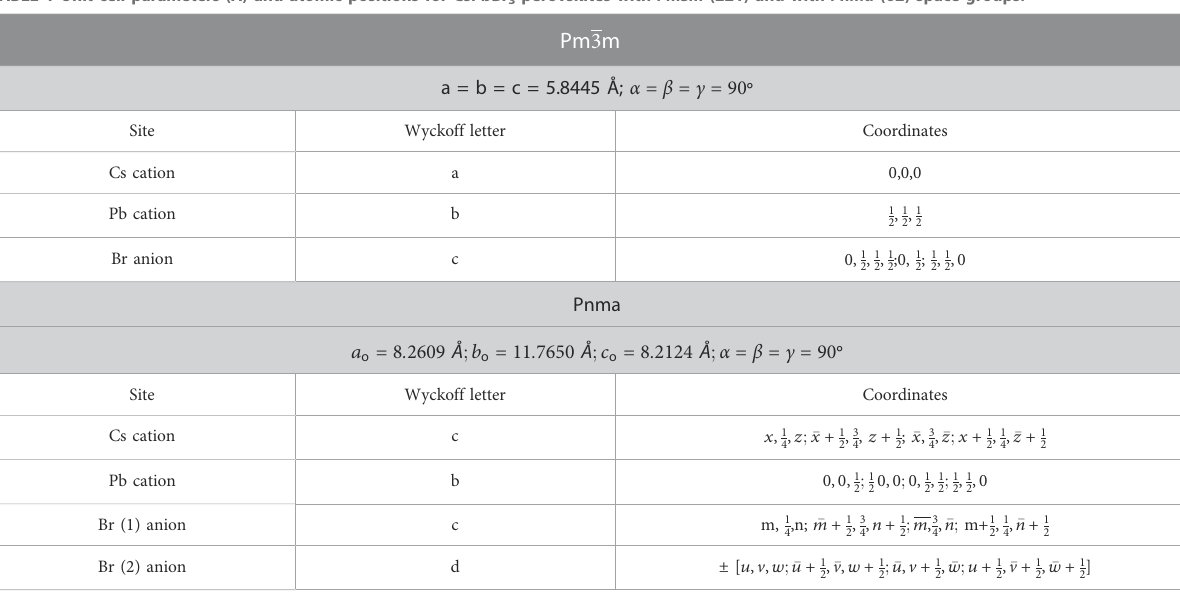
TABLE 1 Unit cell parameters (Å) and atomic positions for CsPbBr 3 perovskites with Pm3 (cid:1) m (221) and with Pnma (62) space